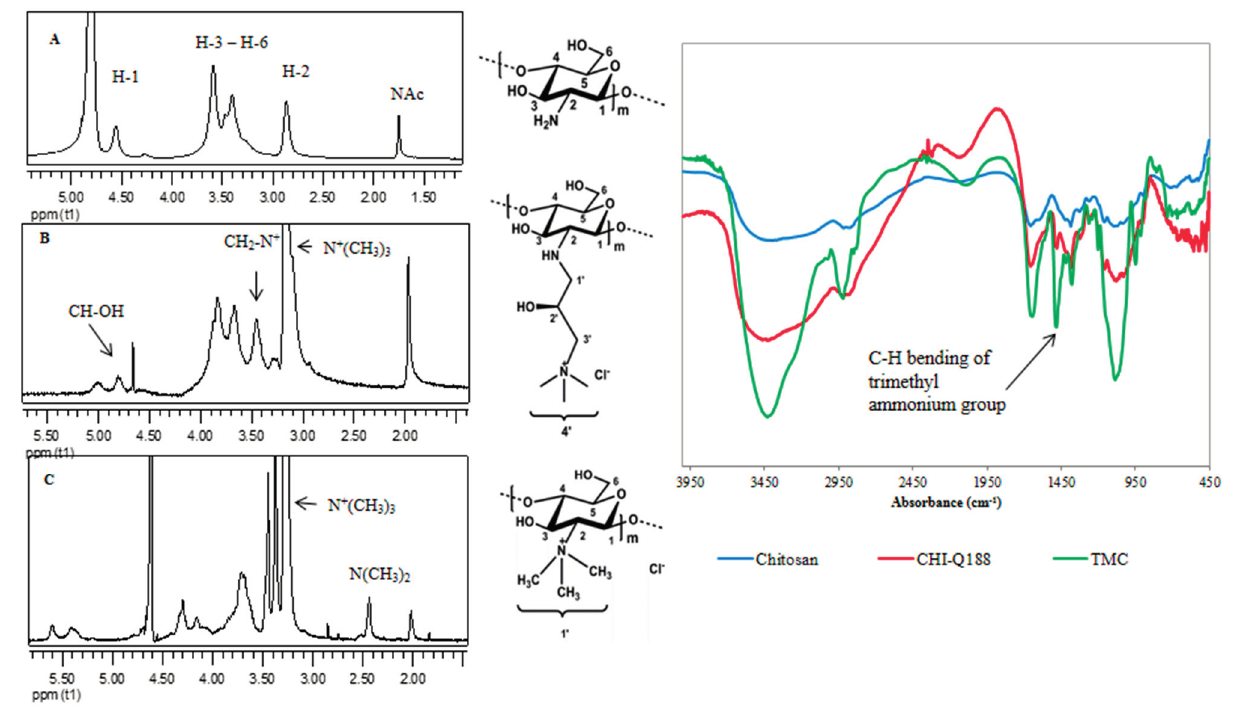
Figure 3. 1 H NMR ( left ), polymer structures ( middle ) and IR spectrum ( right ) of ( A ) chitosan, ( B ) CHI-Q188 and ( C )